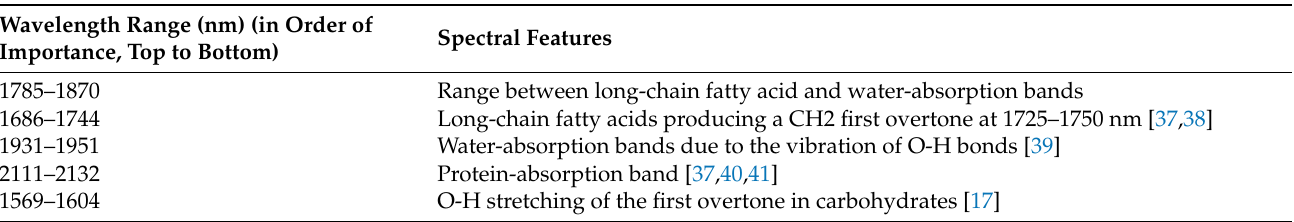
Table 5. Important wavelength ranges for the ensemble model and spectral features located in these ranges. The wavelength ranges are listed in order of importance from top to